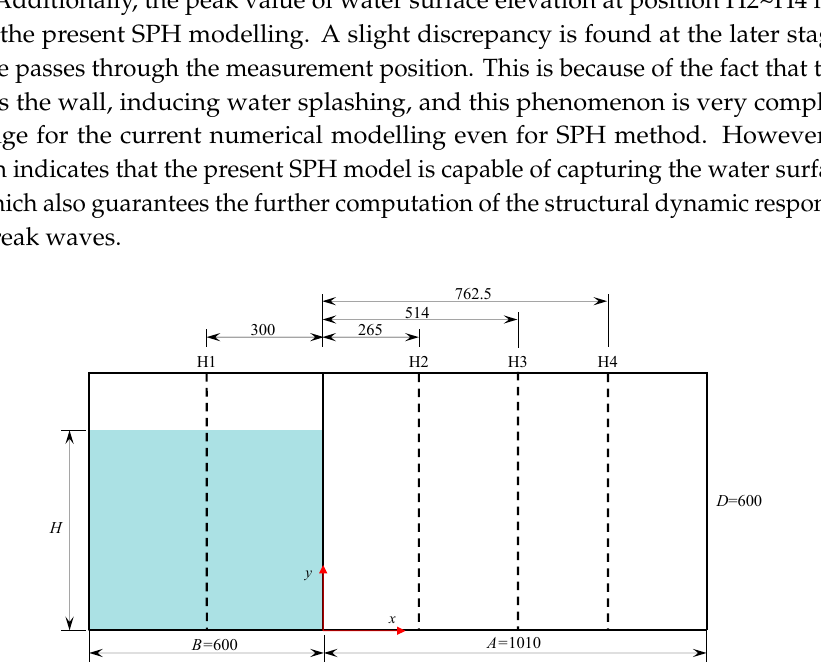
Figure A2. Comparisons between numerical and experimental results of water surface elevations at different locations: ( a ) H1; ( b ) H2; ( c ) H3; ( d ) H4.